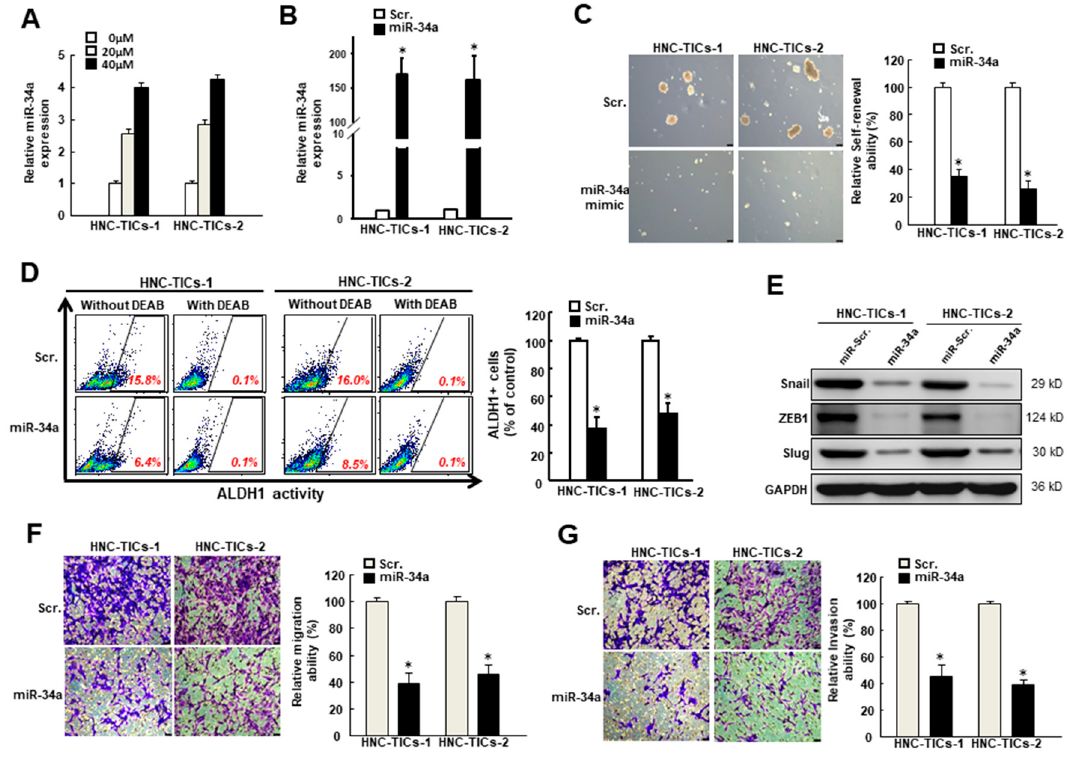
Figure 5. ( A ) The relative expression of miR-34a in two HNC-TICs (tumor-initiating cells of head and neck cancers) after treatment of various concentration of genistein using real-time qRT-PCR; ( B ) The transfection efficiency of scramble (Scr) and miR-34a mimic-transfected cells was measured using real-time qRT-PCR; ( C ) Relative self-renewal ability and ( D ) ALDH1 activity of two HNC-TICs with scramble control or overexpression of miR-34a; ( E ) The expression of Snail, ZEB1 (zinc finger E-box binding homeobox 1), and Slug in HNC-TICs with overexpression of miR-34a using Western blotting; GAPDH (glyceraldehyde-3-phosphate dehydrogenase) was used as the internal control. Relative ( F ) migration and ( G ) invasion capacities in miR-34a-overexpressing TICs. Original magnification: 100×; scale bar: 100 μ m * p < 0.05 compared to scramble control.